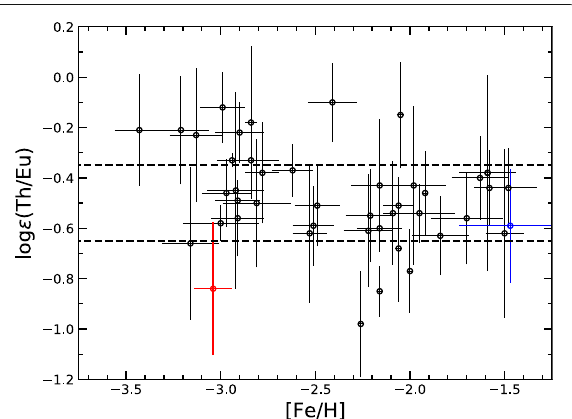
Fig. 5 Observed abundance of Th/Eu in metal-poor stars in the Milky Way (black), Reticulum II (red) and Ursa Minor (blue). Data is generated using the SAGA database [111] and adapted from Refs. [112–134]